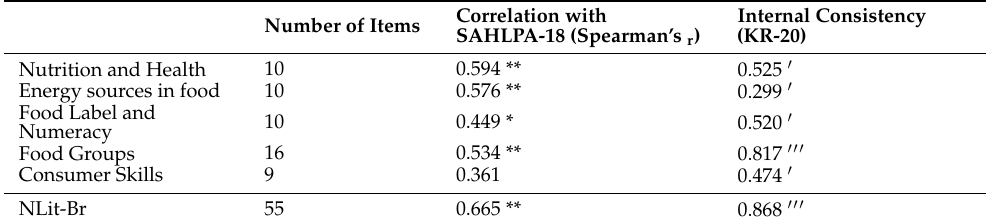
Table 3. Validity and reliability statistics for the Nutrition Literacy Assessment Instrument in Brazilian Portuguese ( n =